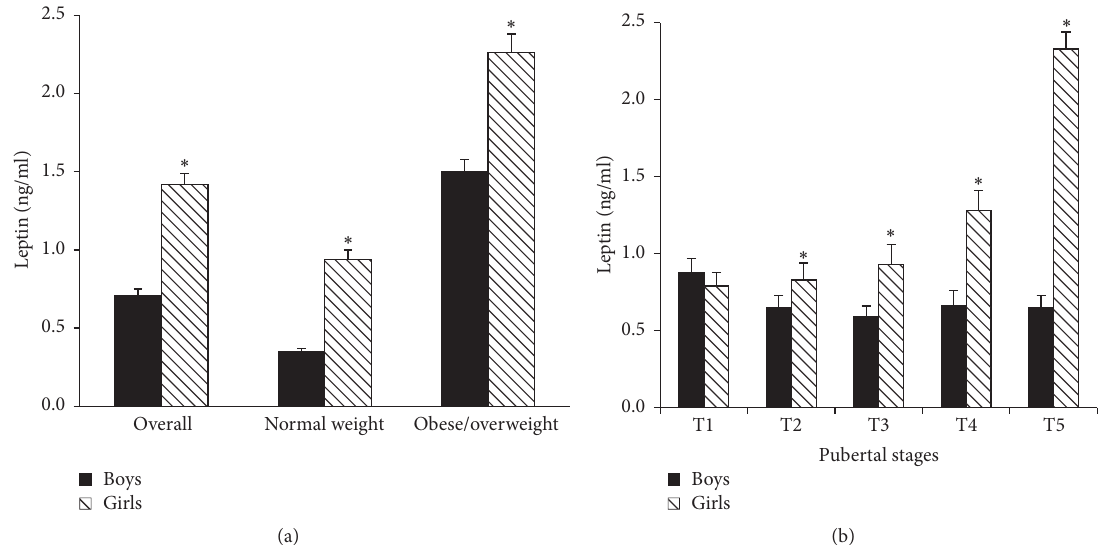
Figure 4: Serum leptin levelsbetween boys and girls in different nutritional states (a) and different pubertal stages (b) ((a) ∗ compared with boys, 𝑃 < 0.01 ; (b) ∗ compared with boys, 𝑃 < 0.05 ).